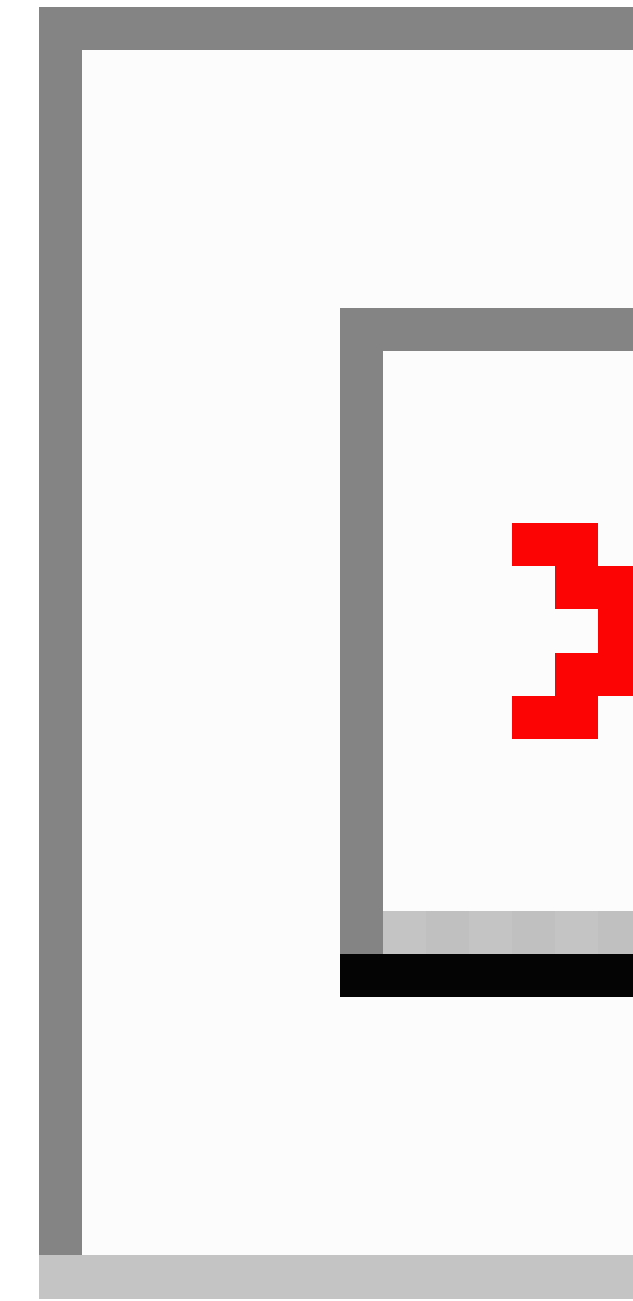
Figure 1. Intelligent Internet Medical Research